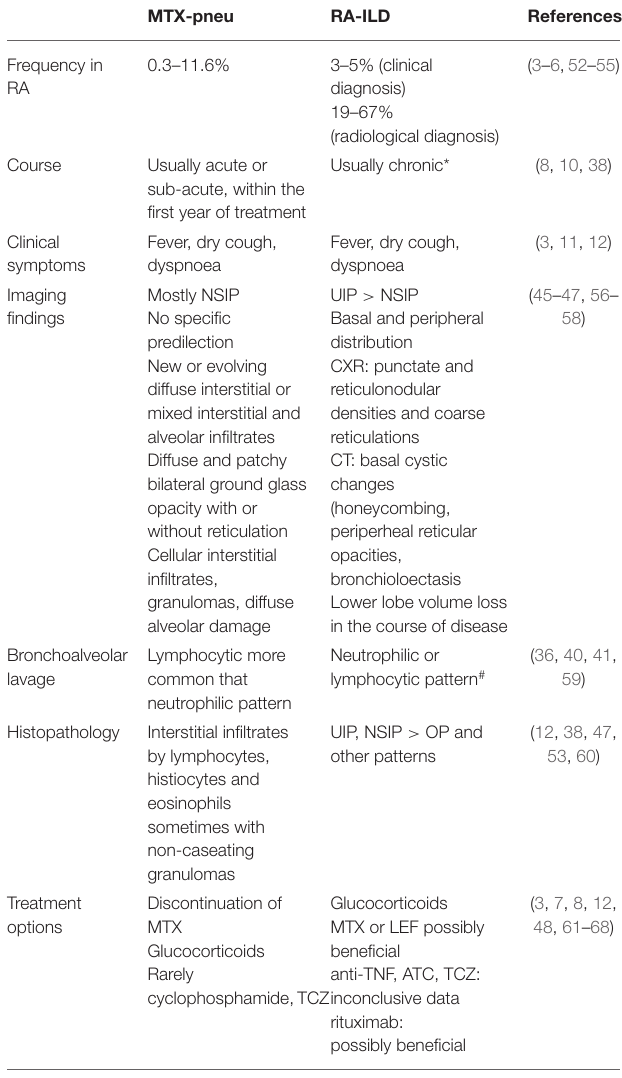
TABLE 2 | Comparison of clinical and imaging features in M-pneu vs.